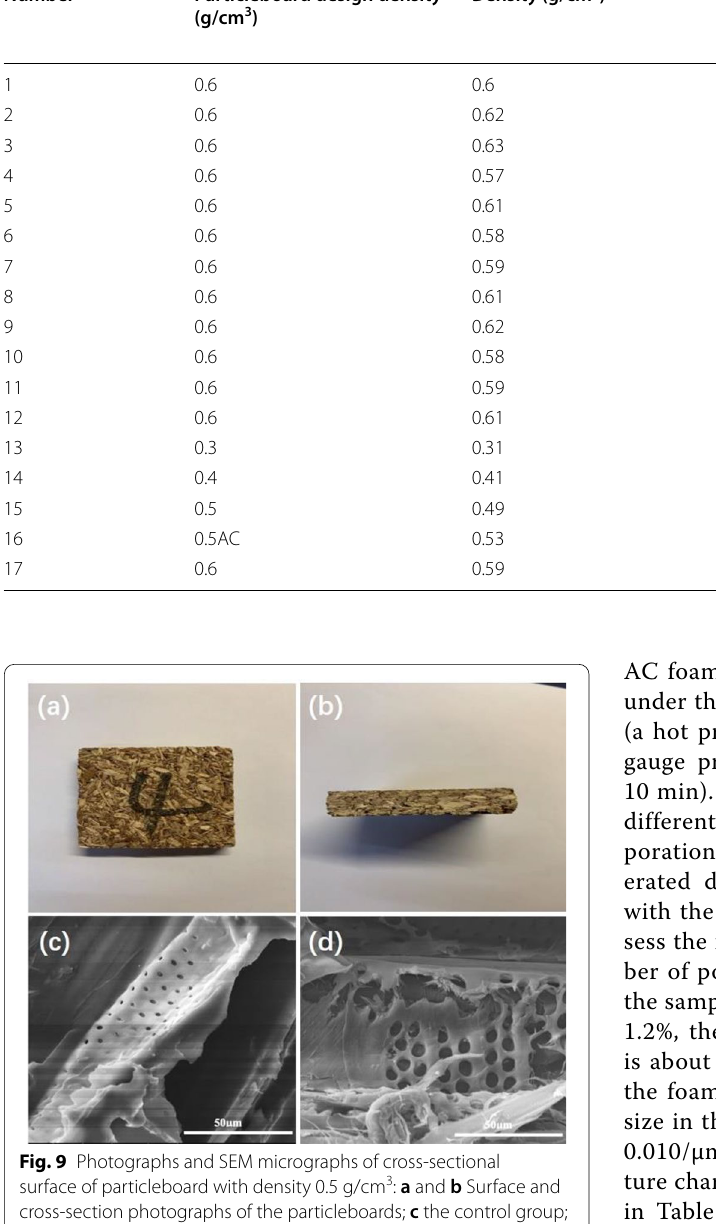
Table 4 Heat conductivity of particleboard in different proportions Number Particleboard design density (g/cm 3 )